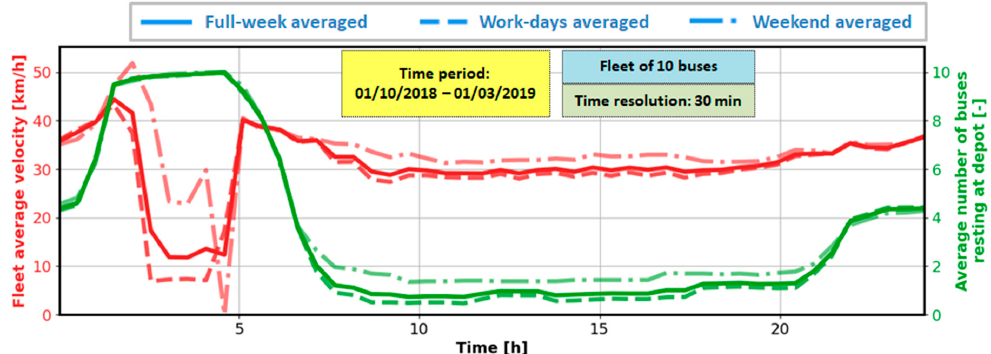
Figure 6. Time profiles of fleet average velocity and average number of buses resting at the depot, both given on daily basis and averaged over the considered five-month period.